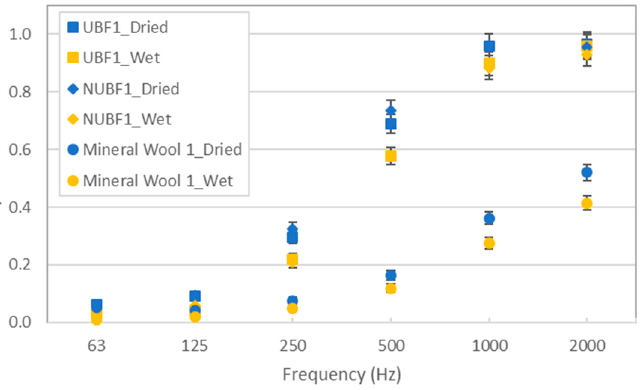
Figure 5. Variation in absorption coefficient with the degree of humidity in the analyzed samples (octave bands).